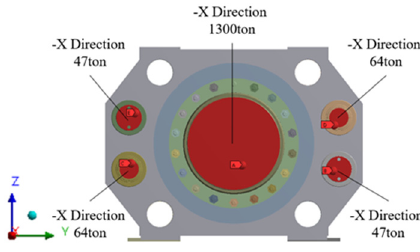
Figure 3. Tie rod load conditions. Figure 4. Cylinder load